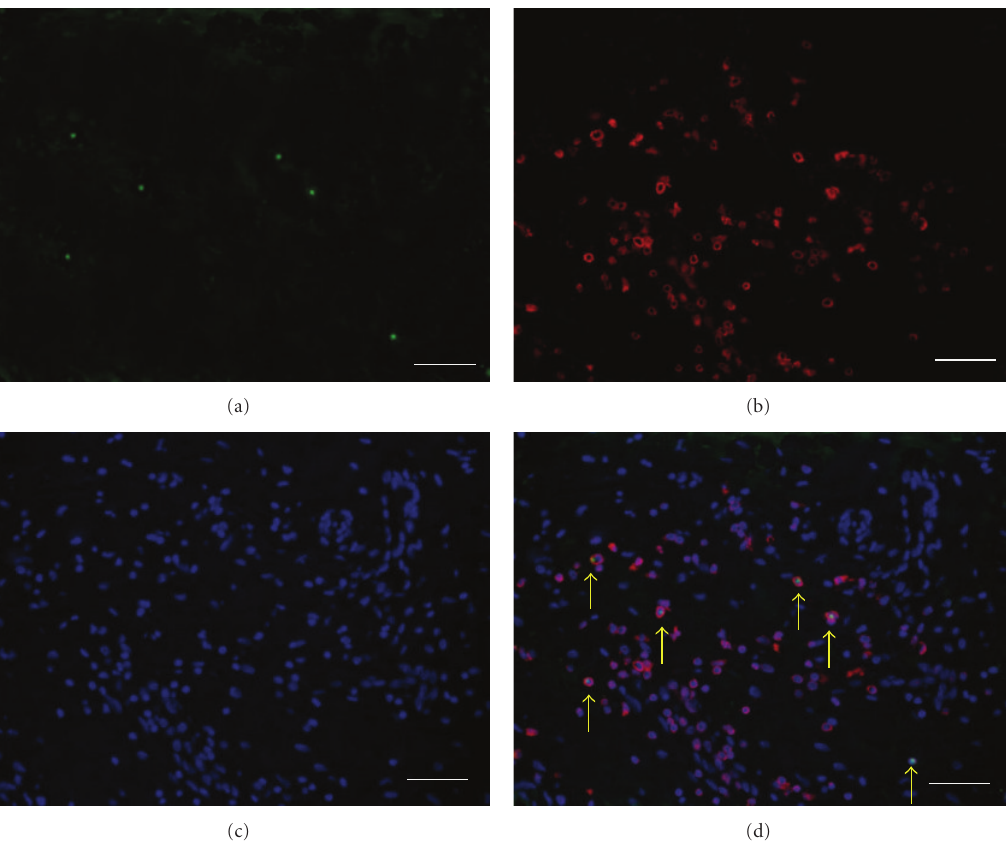
Figure 1: Identification of the cells expressing FOXP3 among CD3 positive cells in human allergic nasal mucosa by means of immunofluorescence technique as follows: (a) the FOXP3 protein (green), (b) CD3 (red), (c) nuclear stain with 4 (cid:3) ,6 diamidino-2- phenylindole (DAPI: blue), and (d) The overlay images. The immunoreactivity for FOXP3 was significantly detected in nucleus of some CD3 positive cells. Scale bar = 100 μ